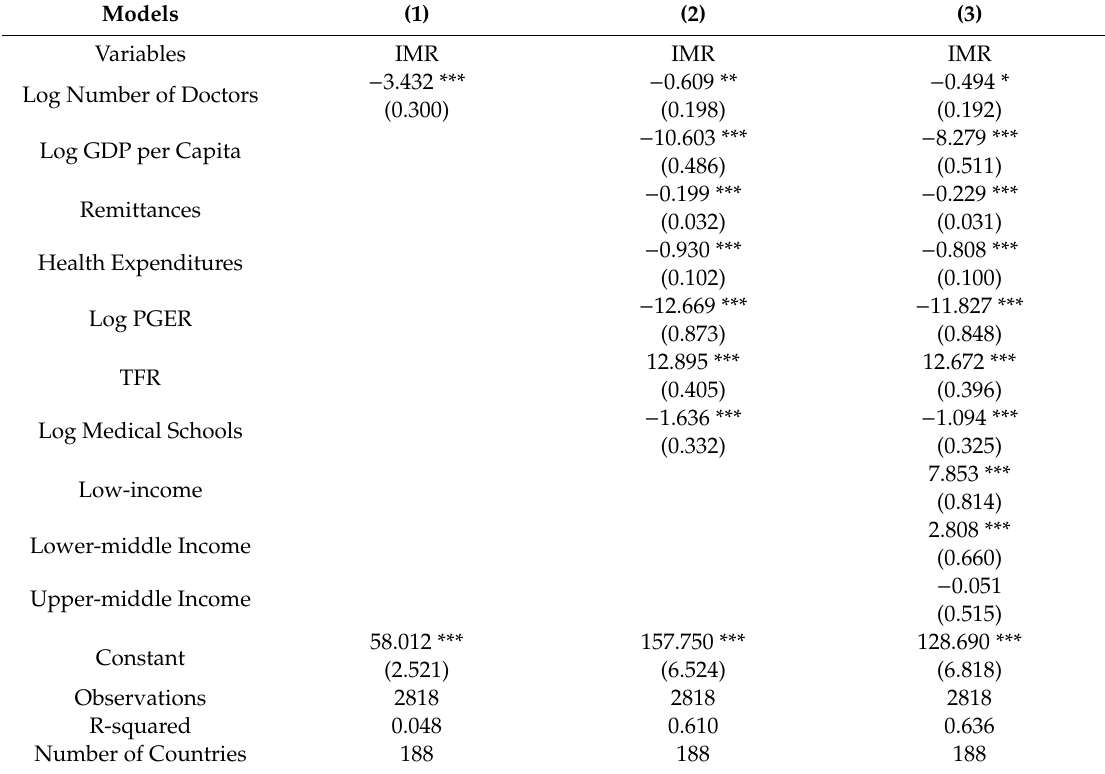
Table 3. Fixed-e ff ects regression of total number of doctors (logged) on IMR in 188 countries over